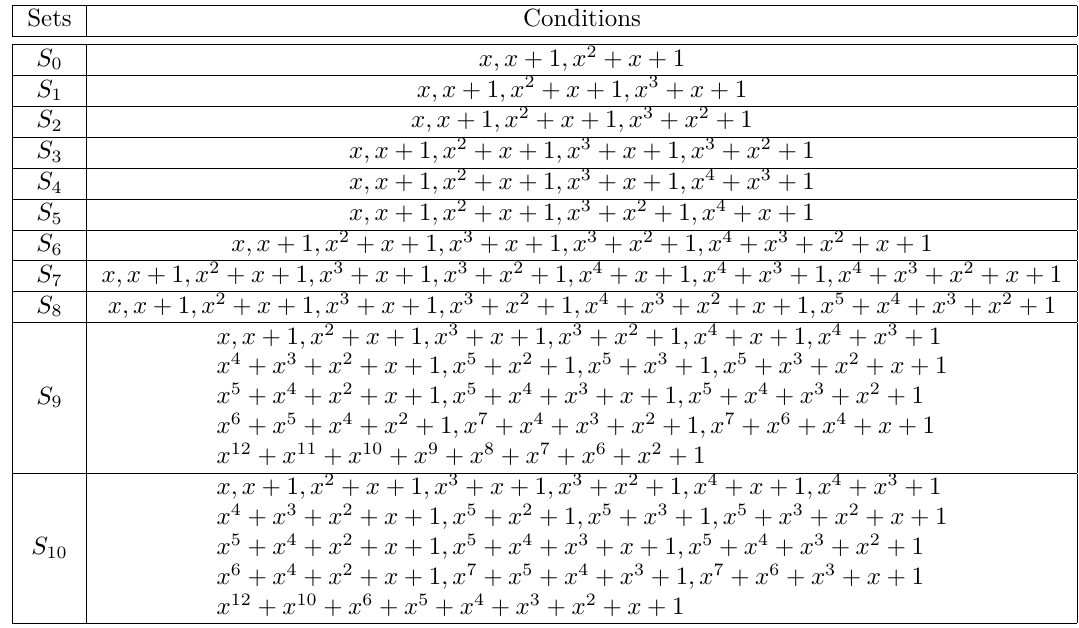
Table 10: Condition sets in Table